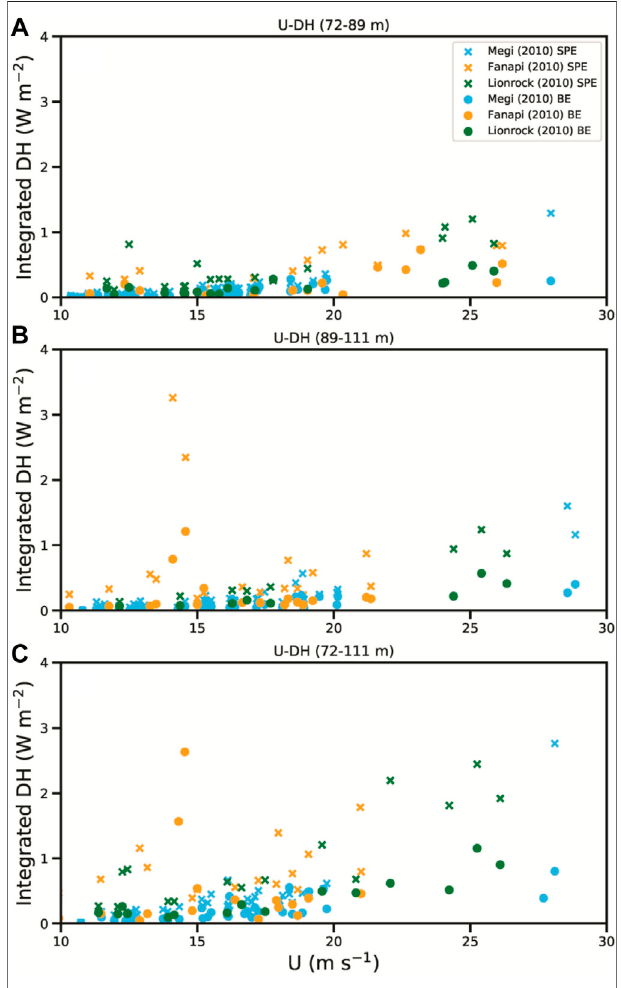
FIGURE 6 | Plots of the DH integrated between (A) 72 and 89 m, (B) 89 and 111 m, and (C) 72 and 111 m by the BE method (diagonal-cross symbols) and turbulent spectra method (solid dots) as a function of the mean wind speed. The green, orange, and blue colors indicate the results regarding Lionrock, Fanapi, and Megi, respectively. Note that the samples with good runs simultaneously identi fi ed at both levels are used.